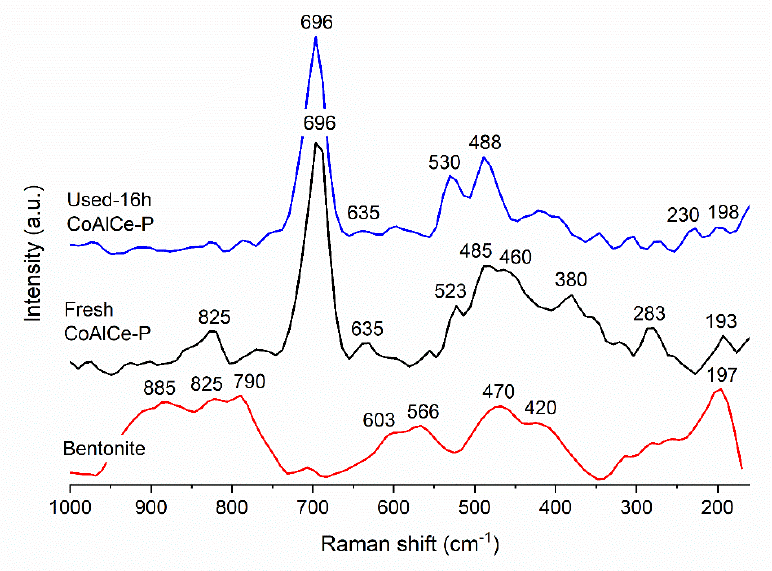
Figure 15. Raman spectra for fresh and 16 h CoAlCe pellet catalysts.